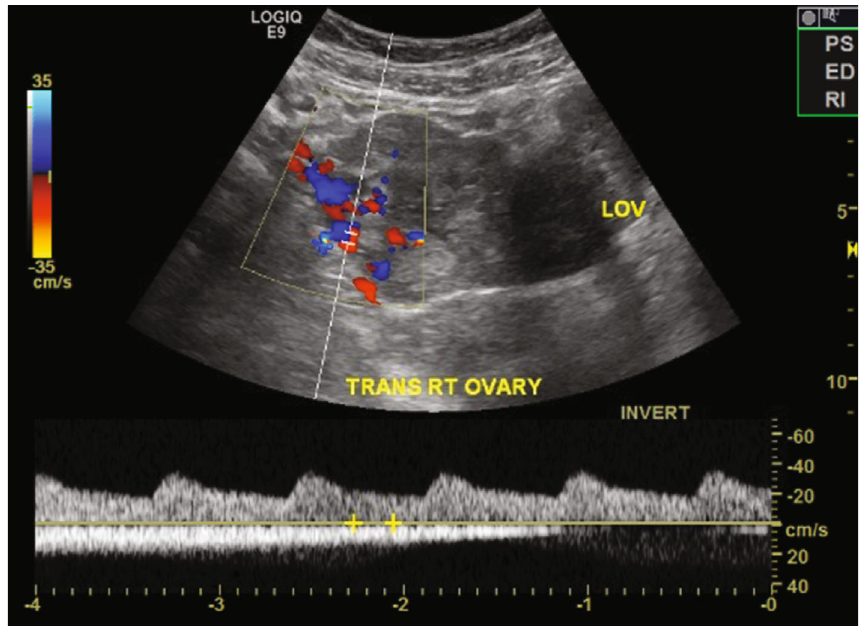
Figure 2: Right adnexa with Doppler fl